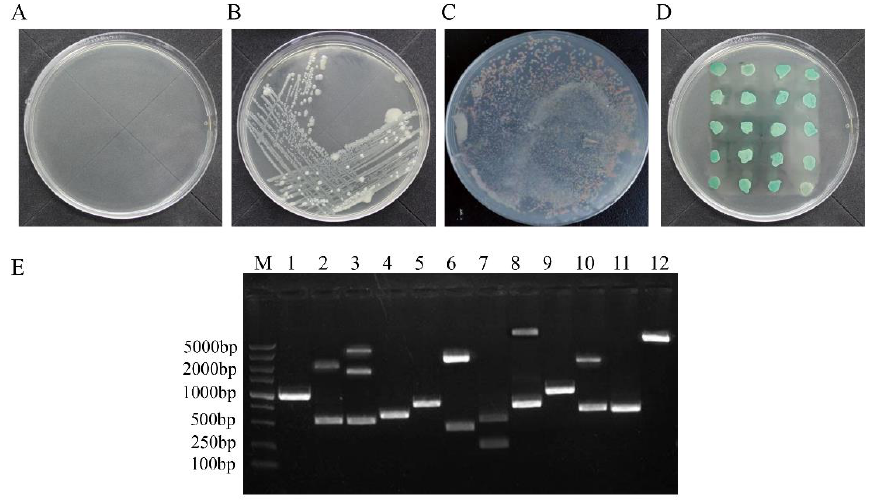
Figure 1. Screening for host proteins that interacted with ARV p17 in a chicken liver cDNA library by yeast two-hybrid assay. ( A , B ) show the negative and positive controls of the transformed competent cells grown on the SD/-His/-Leu/-Trp plate. ( C ) One of the transformed yeast strains cultured on SD/-His/-Leu/-Trp plates. ( D ) One of the SD/-His/-Leu/-Trp/-Ade/X- α -Gal plates on which the blue colonies indicate the positive proteins. ( E ) Identification of the positive clones. Plasmids were extracted from the blue colonies, which was used to amplify cDNA by PCR in the colony.